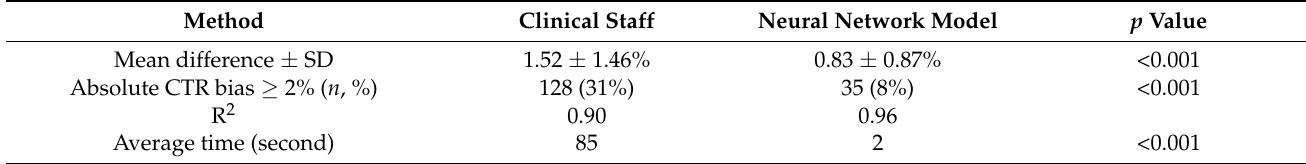
Table 3. Comparison of CTRs calculated by nurse practitioners vs. nephrologists and those calculated by our neural network vs.